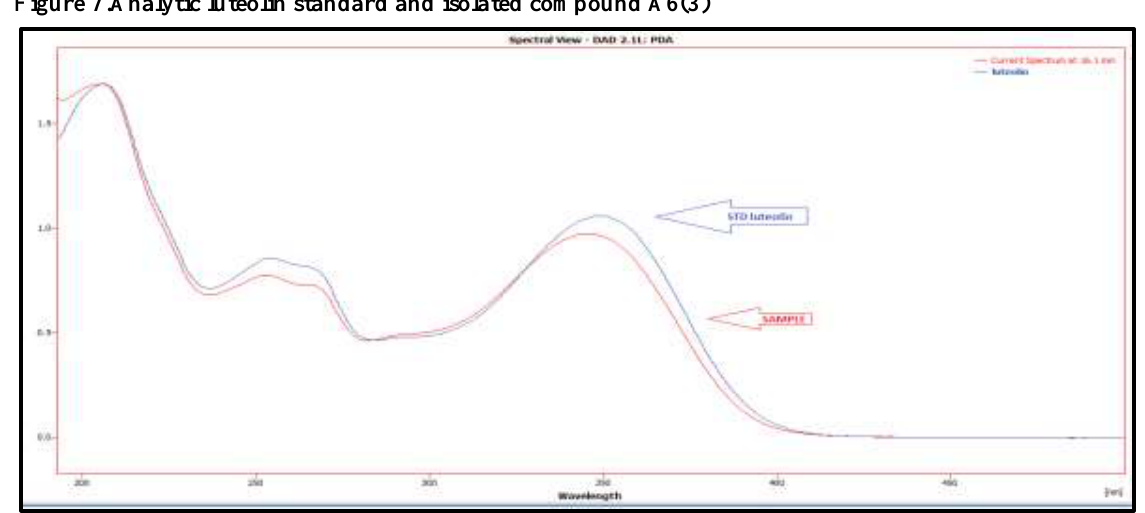
Figure 7.Analytic luteolin standard and isolated compound A6(3)